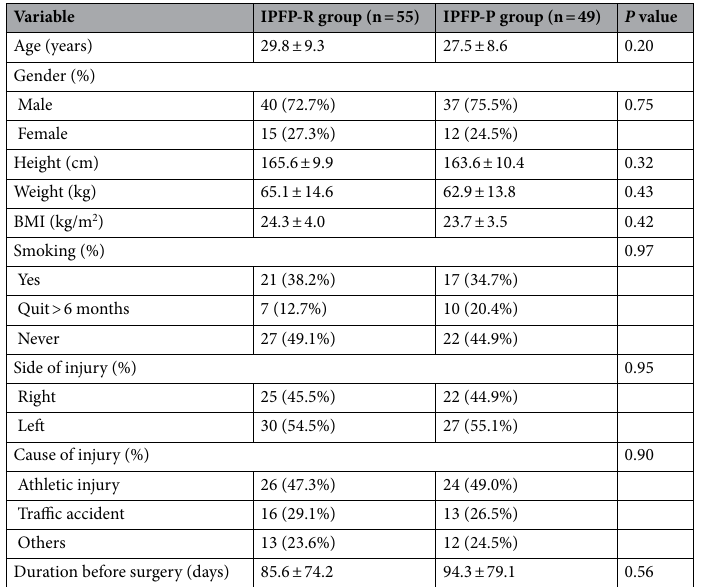
Table 1. Demographics of patients in both groups. Values are expressed as mean ± standard deviation or n (%). IPFP infrapatellar fat pad, BMI Body mass index, IPFP-R infrapatellar fat pad resection, IPFP-P infrapatellar fat pad preservation.